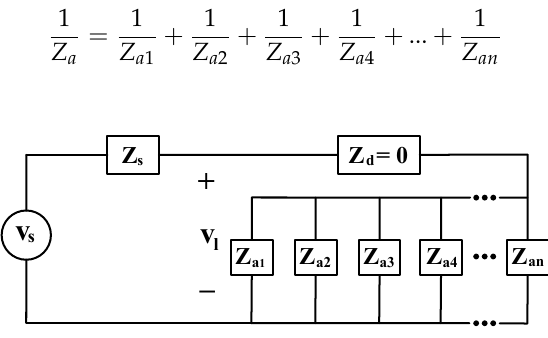
Figure 4. The effect of increasing penetration on load side impedance.